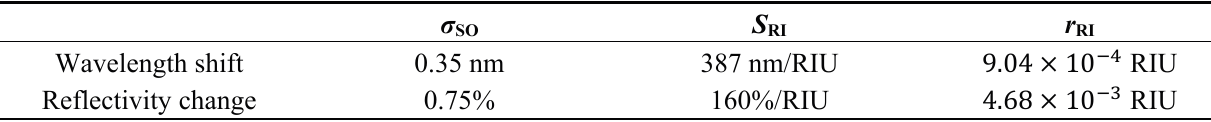
Table 1. Compare of the resolution of the as-prepared LSPR sensor based on wavelength shift and optical intensity change